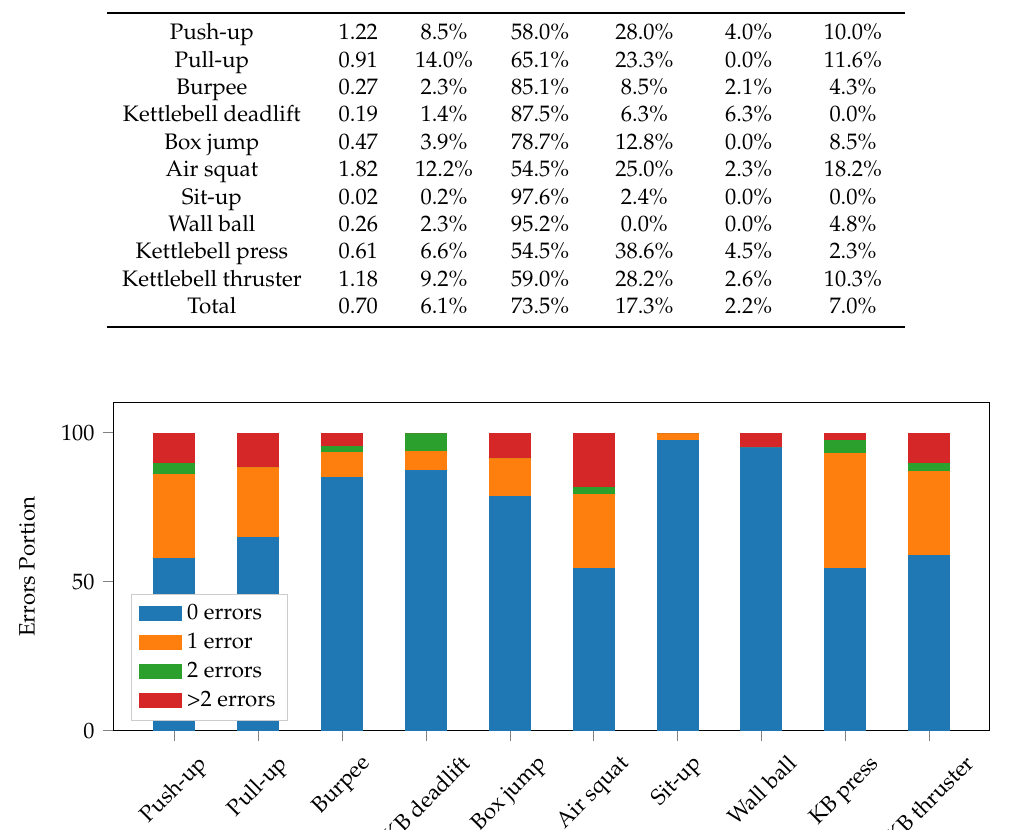
Figure 13. Number of errors of the repetition counting on constrained workout data for the different exercises. The exact values can be found in Table 7.